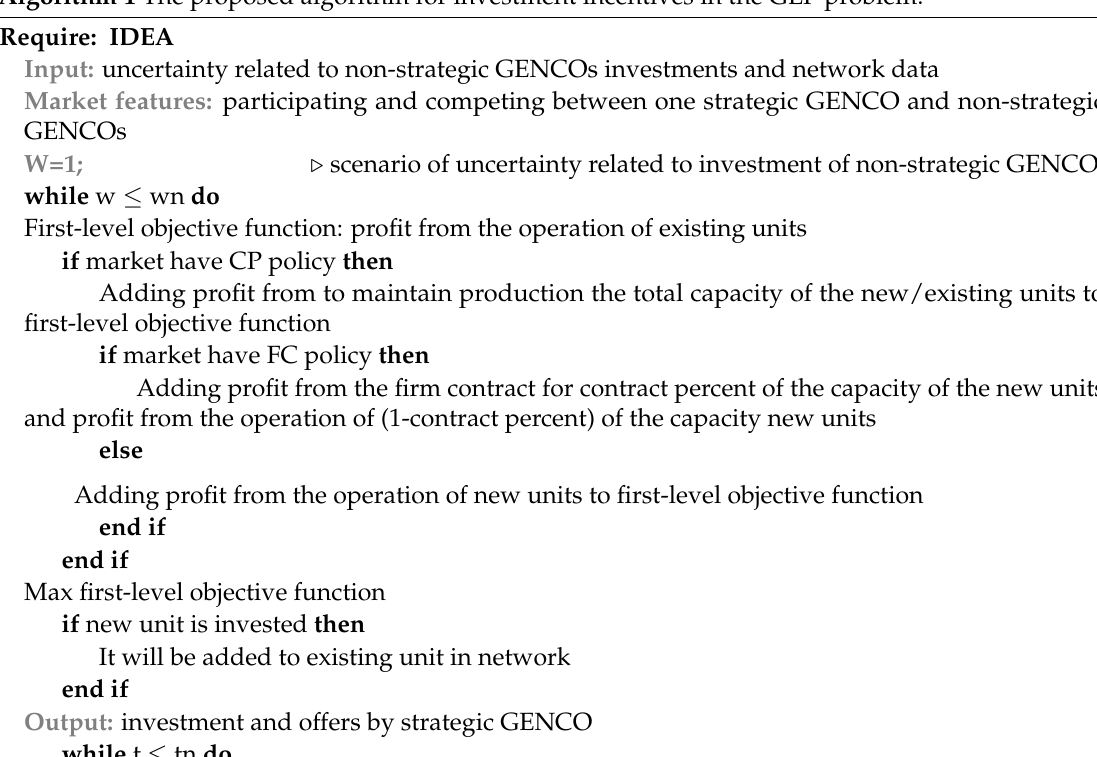
Algorithm 1 The proposed algorithm for investment incentives in the GEP